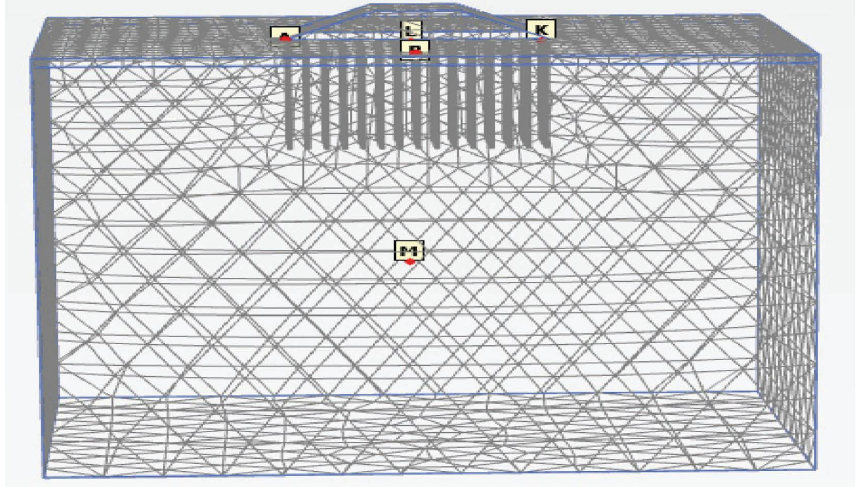
Figure 4: Te deformed mesh under the applied boundary